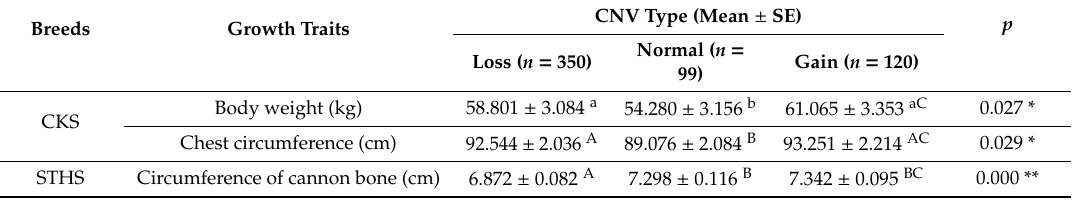
Table 4. Statistical association analysis of ovine PIGY gene CNV with growth traits of three Chinese sheep